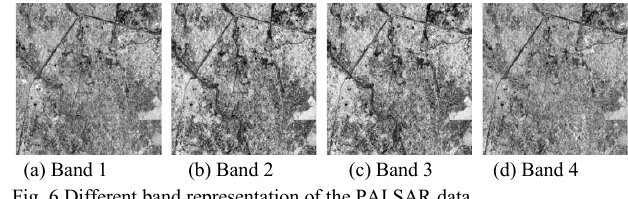
Fig. 6 Different band representation of the PALSAR data Now all the four bands are fused together to obtain a single quad pole image on which the classification schemes are applied. Map